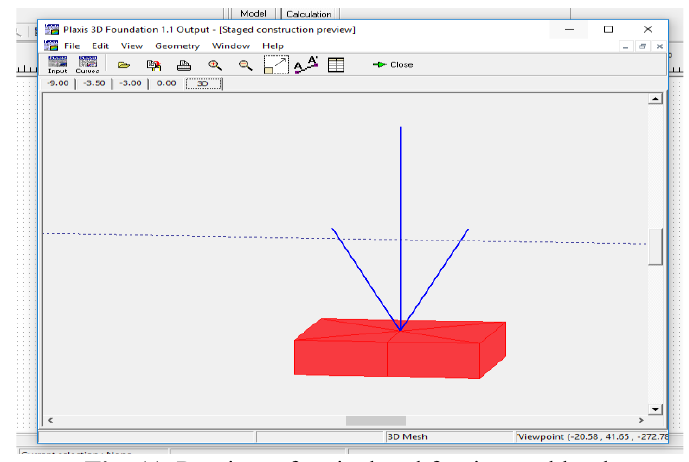
Fig. 11. Preview of an isolated footing and load.